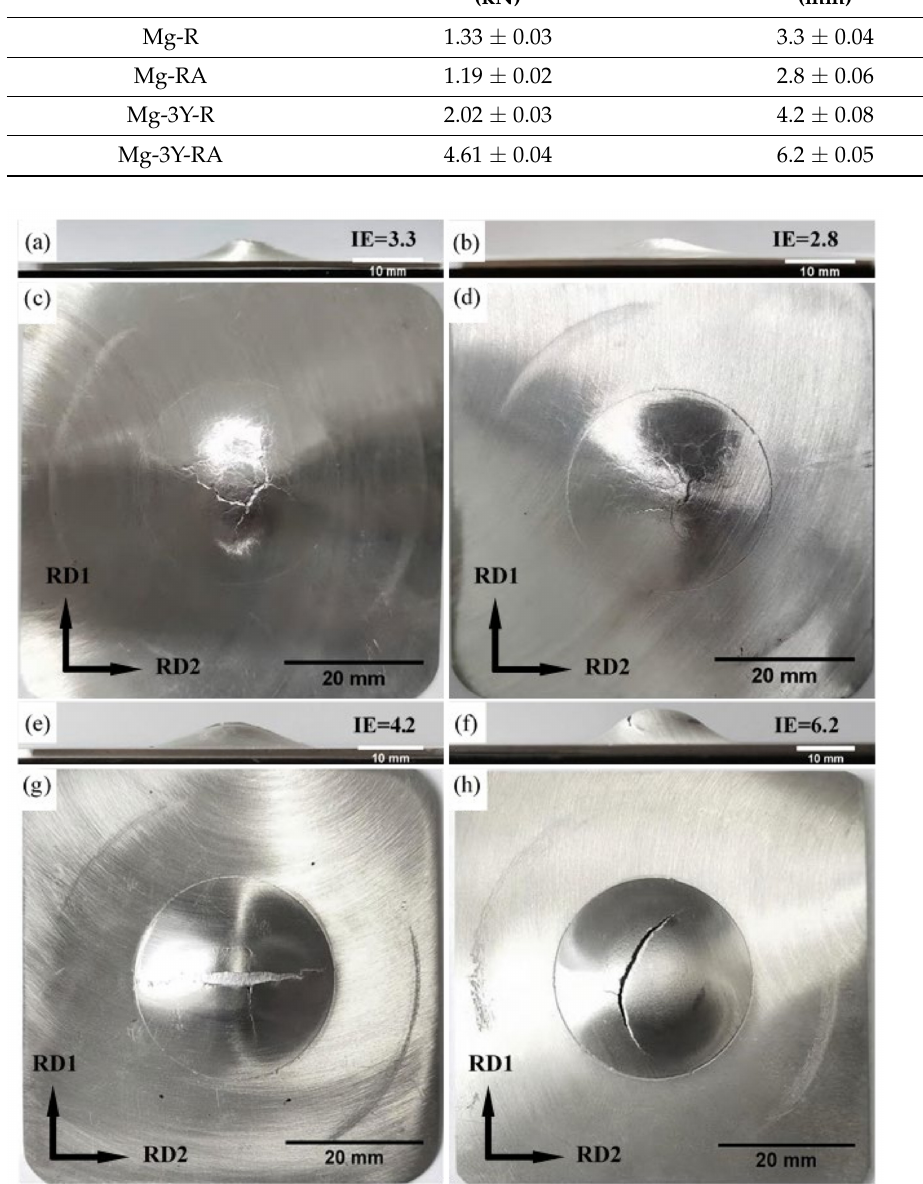
Figure 25. Macro-morphology of specimens after the Erichsen test at room temperature of ( a , c ) as-rolled and ( b , d ) as-annealed pure Mg sheets; ( e , g ) as-rolled and ( f , h ) as-annealed Mg-3Y